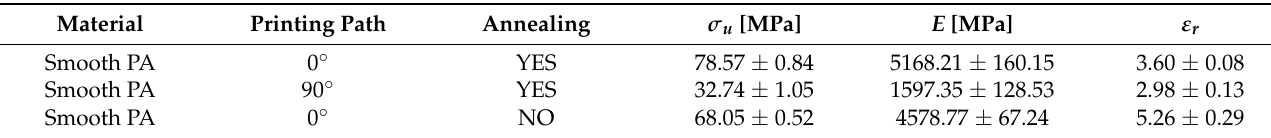
Figure 6. Flash thermography setup.